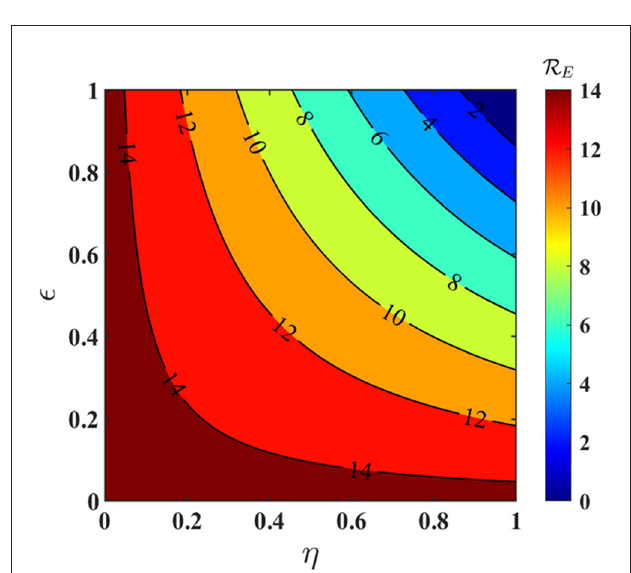
FIGURE6 The contour plot of the effective (or control) reproduction number R E , as a function of the intervention programs ( ǫ ) and the compliance rate ( η ). The other parameter values used for the contour plot are given in Tables 3, 4,